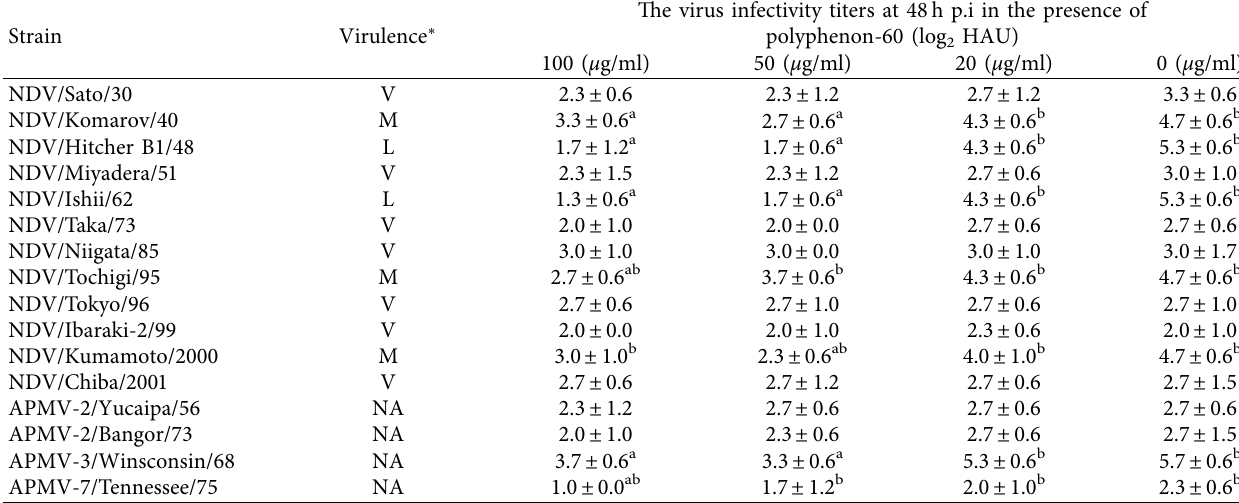
Table 1: Inhibitory effect of polyphenon-60 on the growth of avian paramyxoviruses in CEF cells. The virus infectivity titers at 48h p.i in the presence Strain Virulence ∗